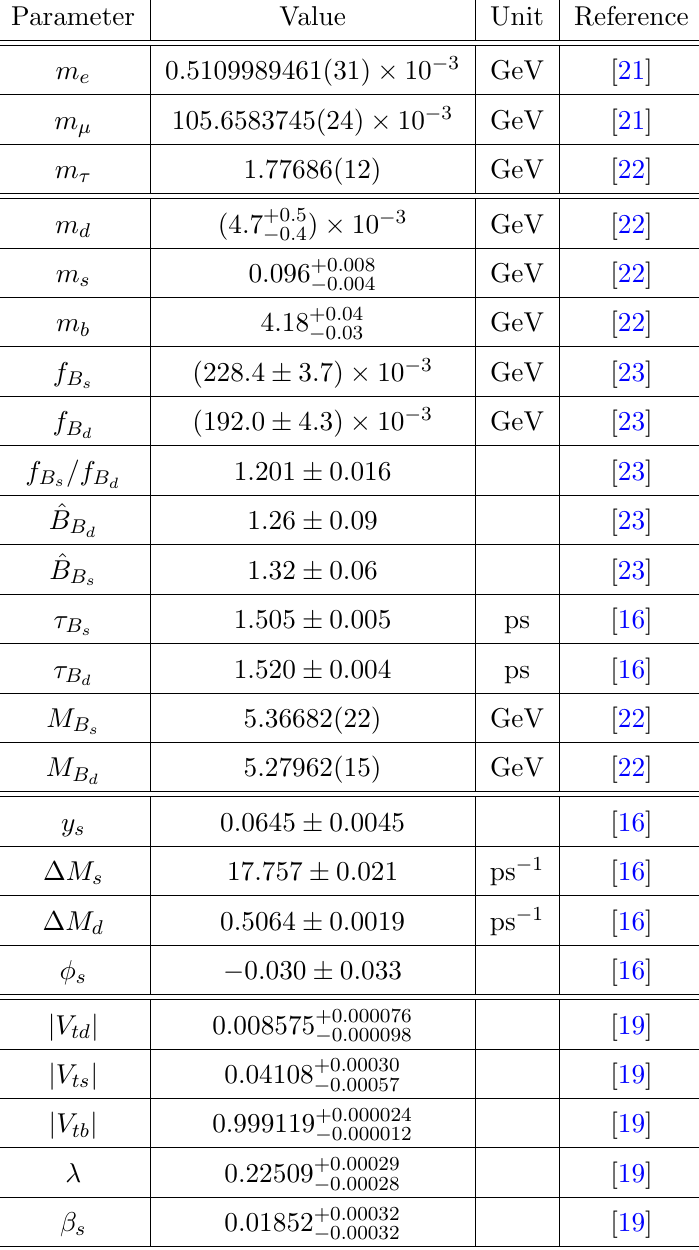
Table 1 . Input parameters used in the numerical evaluations of this paper.